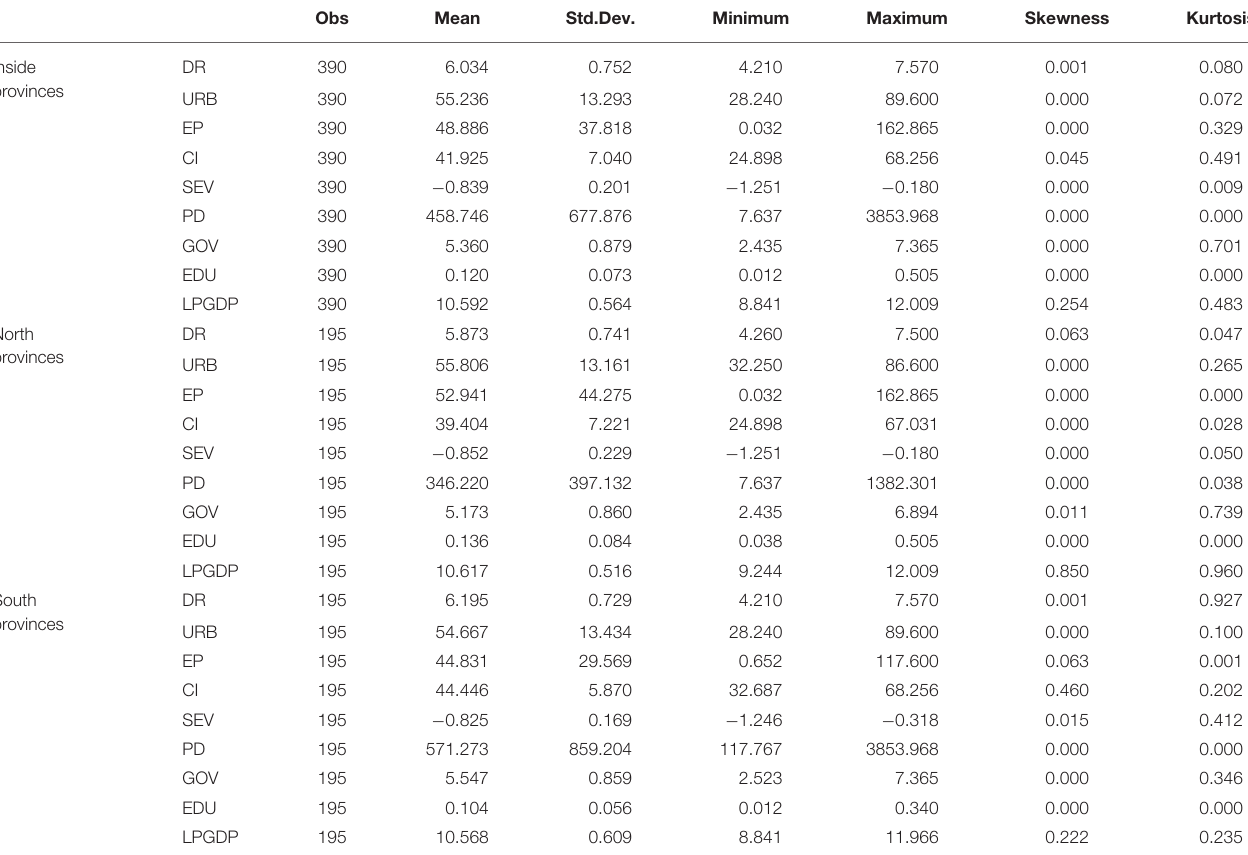
TABLE 1 | Descriptive statistics of the